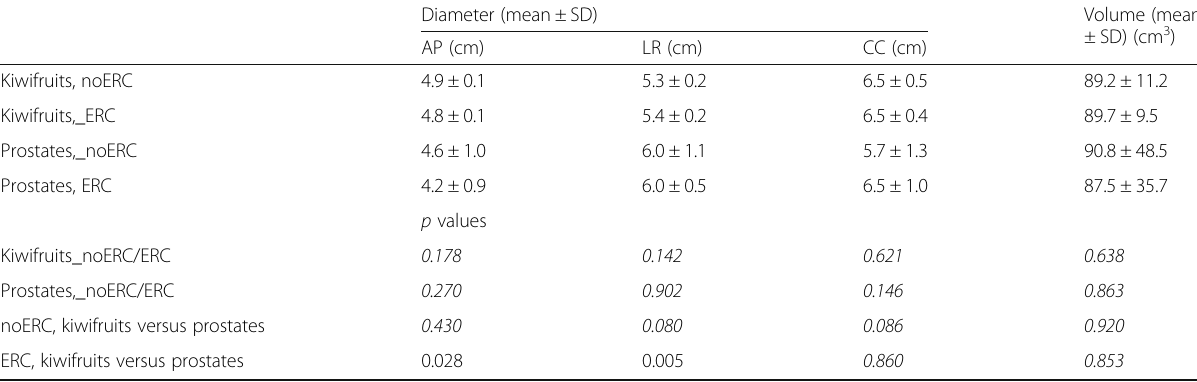
Table 5 Diameters and volumes of kiwifruits ( n = 5) and human prostates (without endorectal coil, n = 10; with endorectal coil, n =